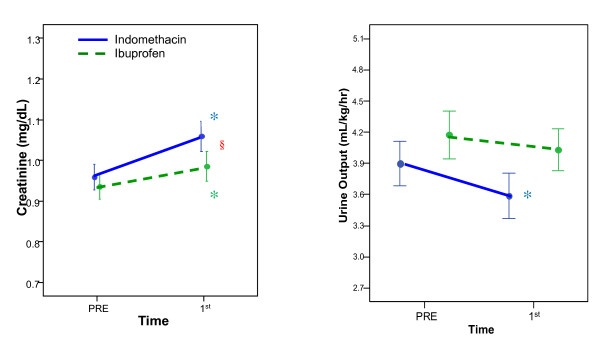
Mean urine output and creatinine values for all patients by drug. Comparison of mean urine output and creatinine values for all patients during the first course of therapy, by treatment drug. Indomethacin group (solid line) and Ibuprofen group (dashed line). PRE - pre-treatment baseline; 1st - end of first course of treatment. * denotes statistically significant (p < 0.05) change from treatment baseline; § denotes statistically significant (p < 0.05) difference in change from baseline between treatment groups.